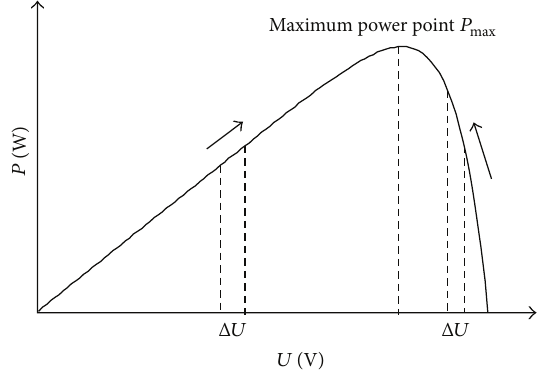
Figure 6: Schematic diagram of the classical perturb-and-observe algorithm.